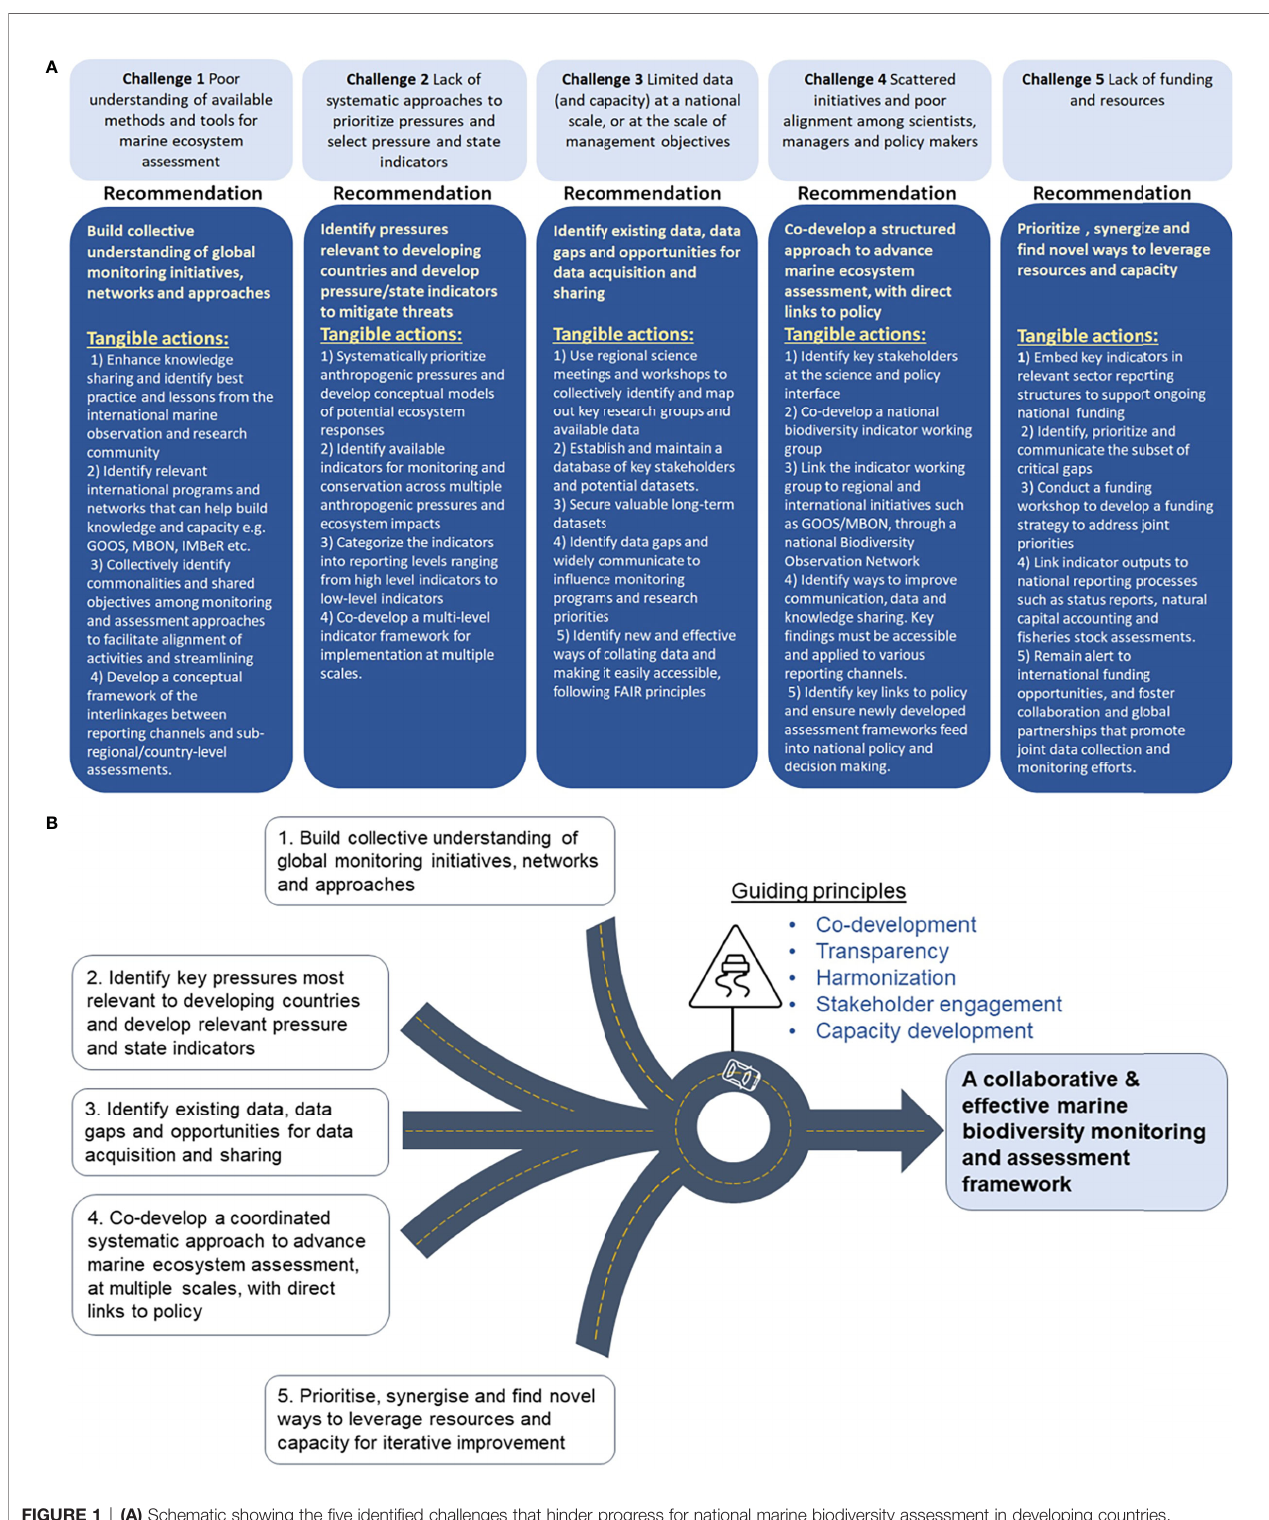
FIGURE 1 | (A) Schematic showing the fi ve identi fi ed challenges that hinder progress for national marine biodiversity assessment in developing countries, recommendations (in bold text at top of each pillar), and tangible actions to overcome these challenges. (B) A roadmap illustrating how the fi ve recommendations, linked to each identi fi ed challenge, should be collectively applied to advance marine biodiversity monitoring and the co-development of an assessment framework. These steps need to be guided by a set of key principles that will enable a harmonized, coordinated, equitable, and sustainable iterative